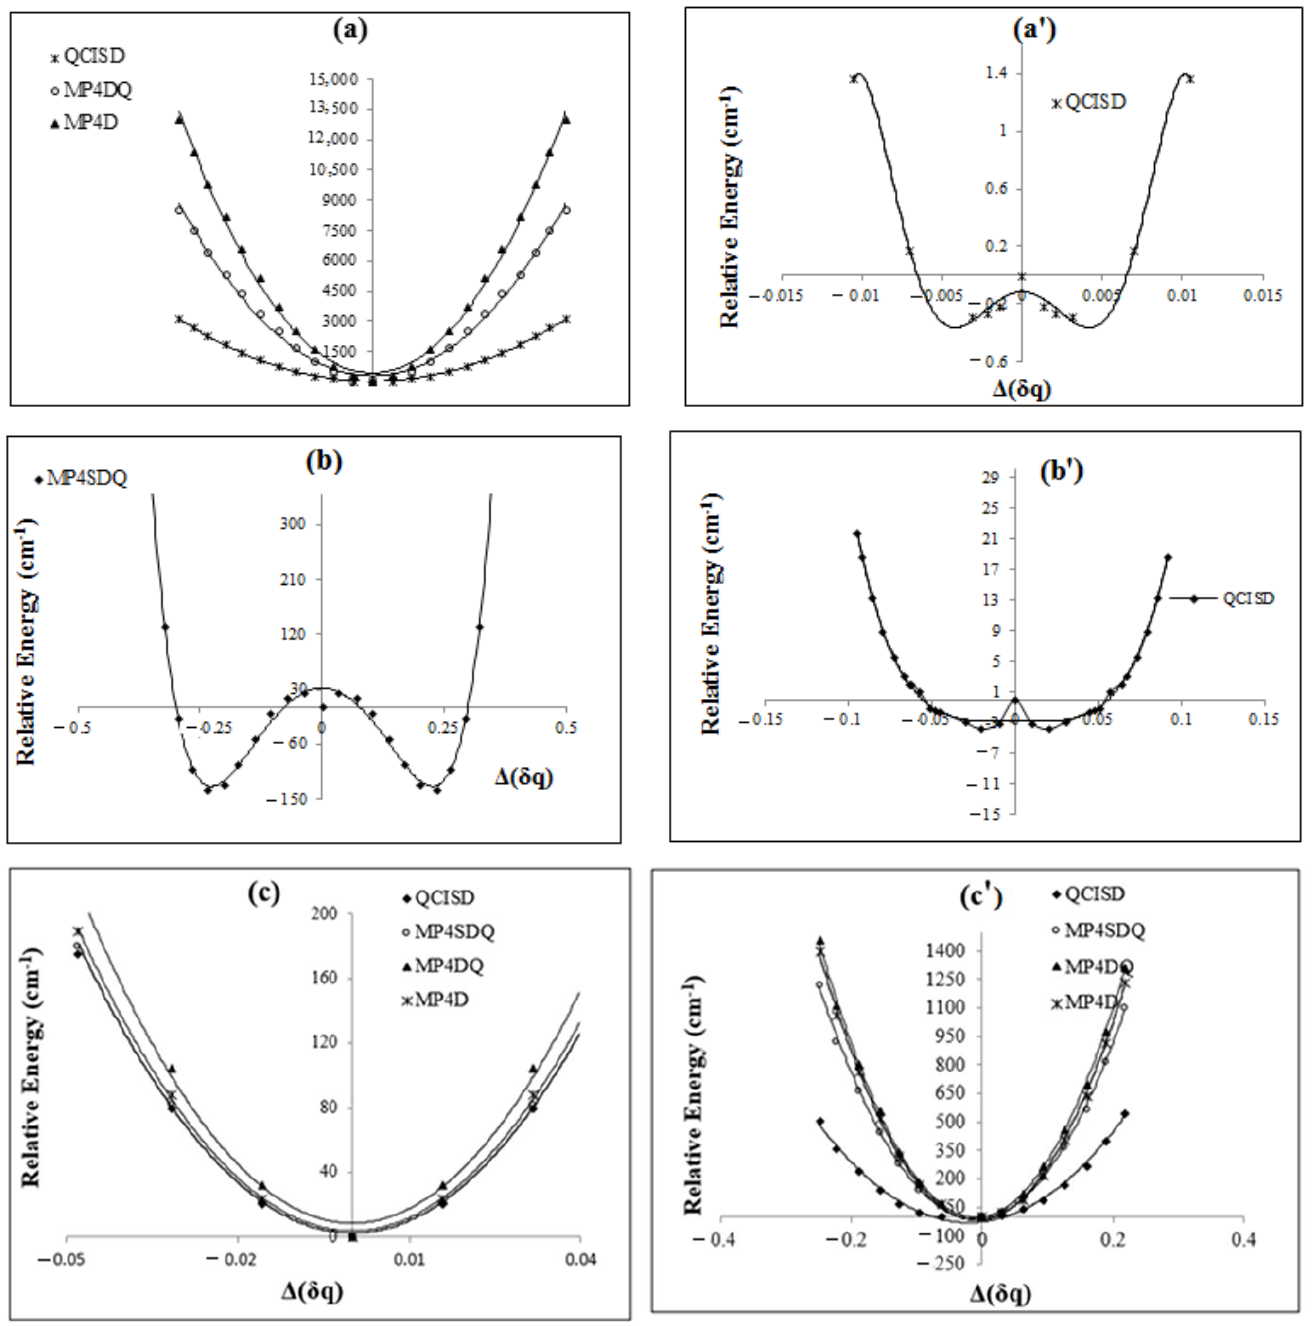
Figure 1. The B 2 𝑁 (−,0,+) relative energies versus B-N-B bond distances at various levels of the the- ory: ( a , a′ ) for cation, ( b , b′ ) for radical and ( c,c ′ ) for anion. ( a , a (cid:48) ) for cation, ( b , b (cid:48) ) for radical and ( c , c (cid:48) ) for